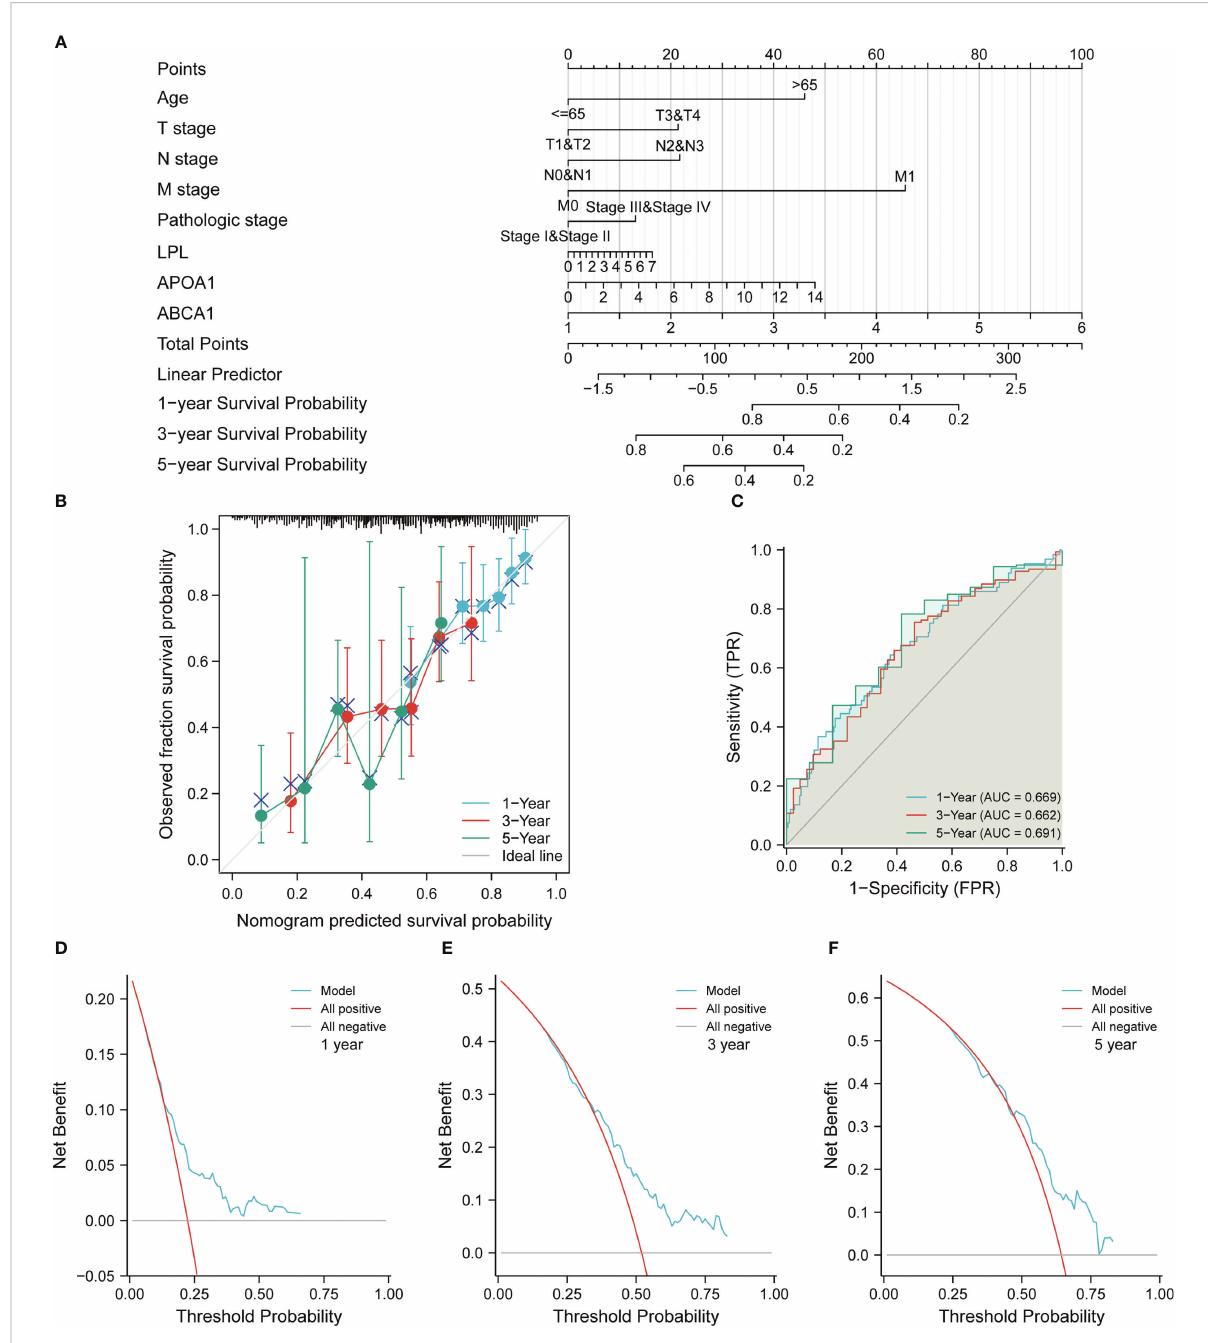
FIGURE 7 Construction and evaluation of nomogram prediction models in the TCGA-STAD cohort. (A) Construction of a nomogram prediction model. (B) Evaluation of calibration curve on the predictive value of the nomogram model. (C) Evaluation of ROC curve on the predictive value of the nomogram model. (D – F) Evaluation of DCA curve on the clinical utility value of the nomogram